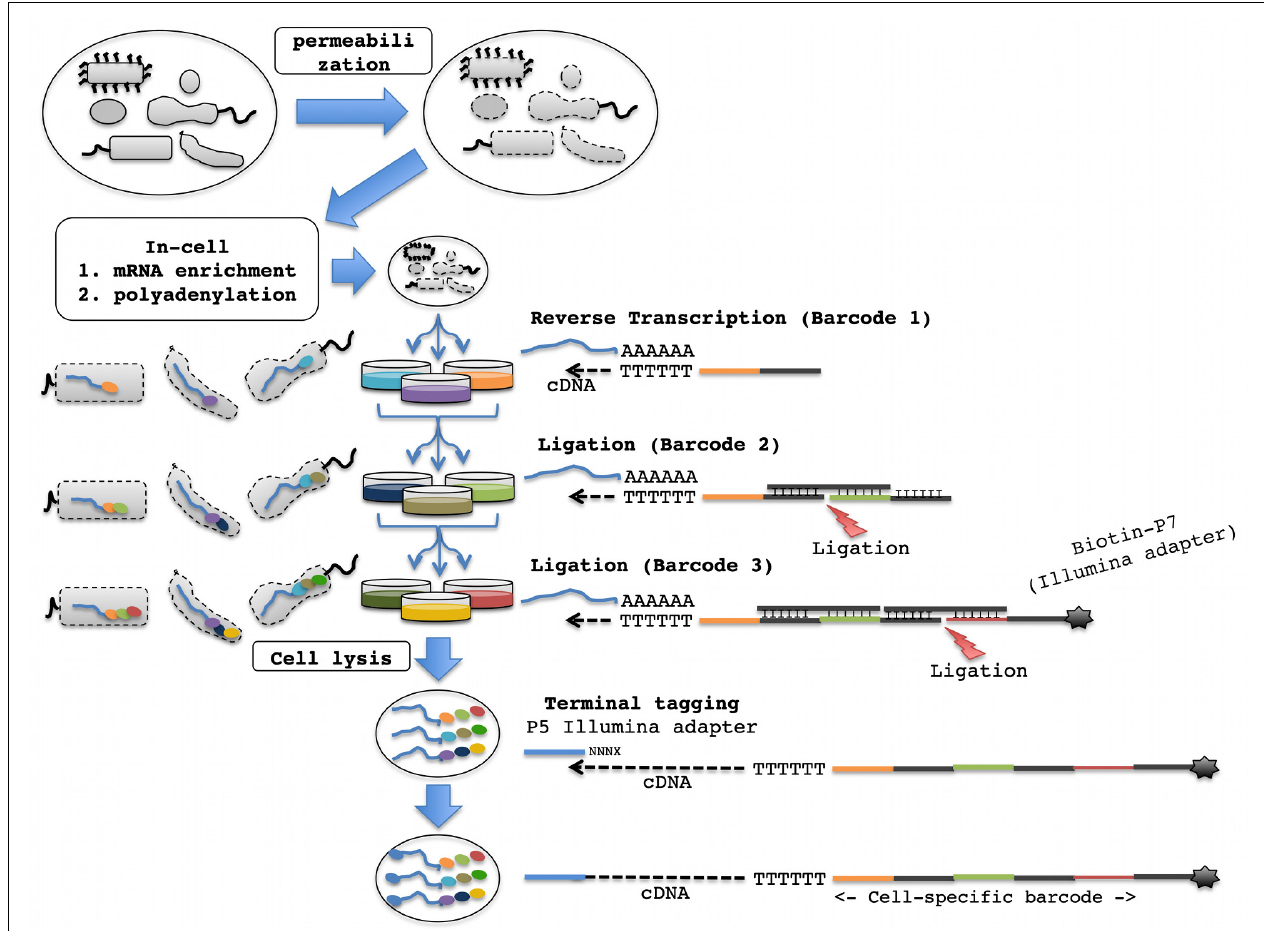
FIGURE 1 | Proposed SPLiT-Seq workflow for scRNA-seq of bacterial communities. Following cell permeabilization and in-cell mRNA enrichment and polyadenylation, the cells go through three rounds of splitting and pooling, first for RT, followed by two rounds for adapter ligation. Wells of different colors depict distinct barcode sequences. Sequential addition of 3 (cid:48) barcodes to a single mRNA molecule followed by terminal tagging to add the 5 (cid:48) adapter is depicted on the right. The sequential addition of barcodes to mRNA molecules in different bacterial cells at each split-pool round is depicted on the